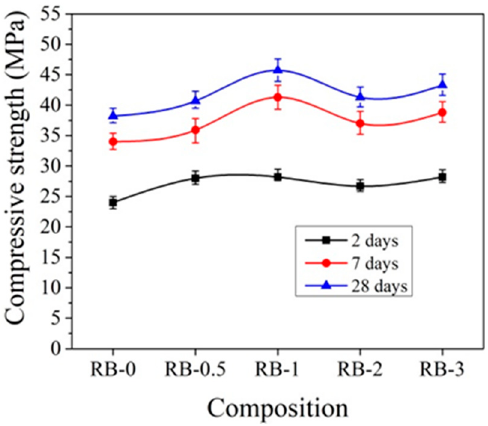
Figure 9. Compressive strength of concrete with CEM IIR samples at +20 °C curing.